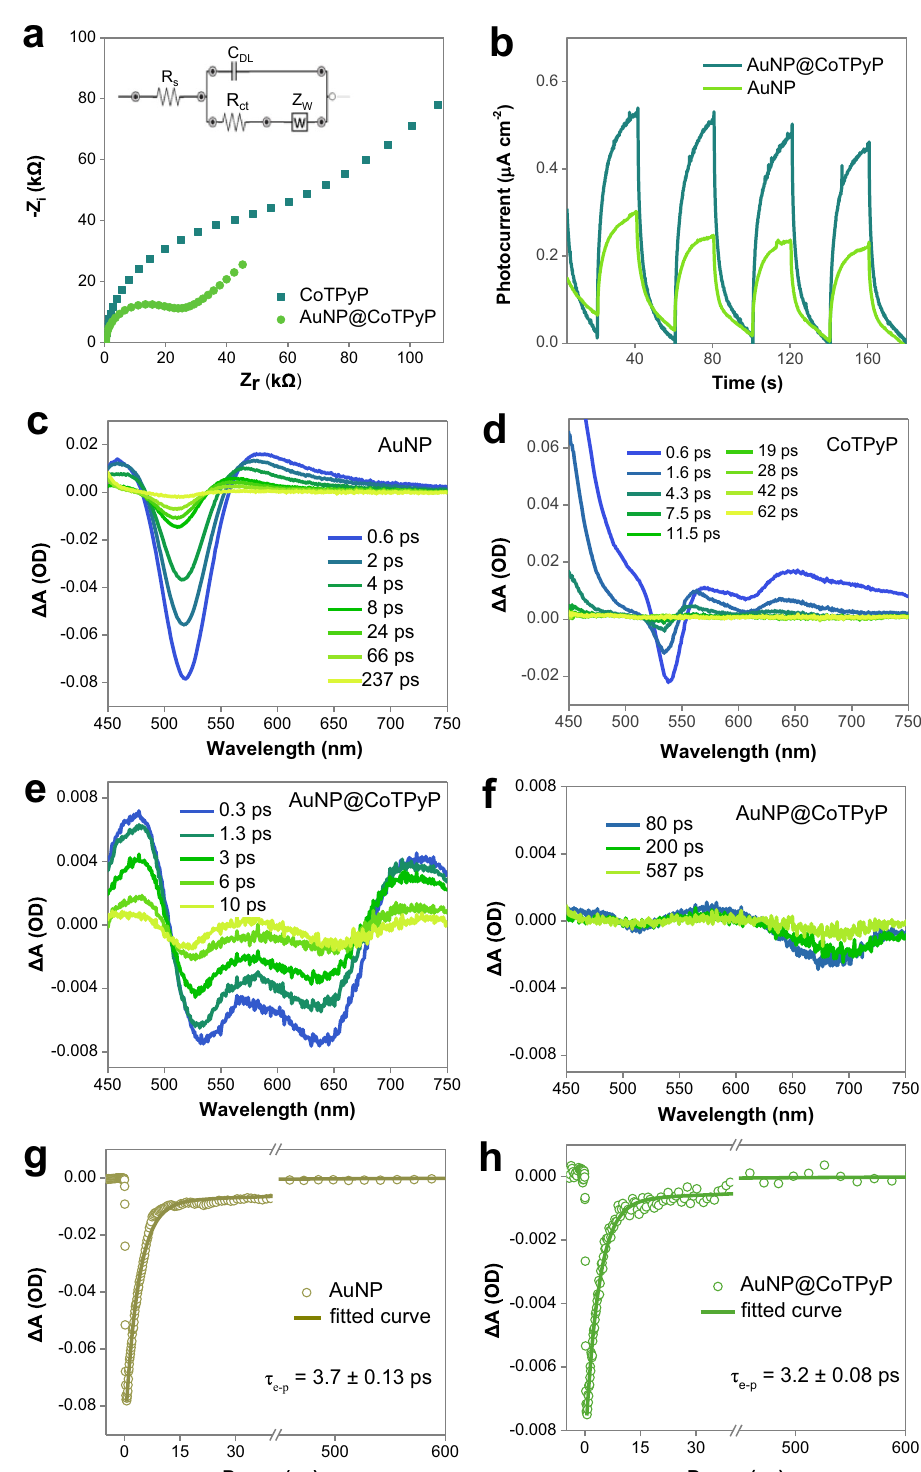
Fig. 5 | Contribution of the enhanced hot carrier transfer in AuNP@CoTPyP photocatalysis. a Nyquist plots of CoTPyP and AuNP@CoTPyP in H 2 SO 4 solution (pH=4). b PhotocurrentmeasurementsoftheAuNPsandAuNP@CoTPyP(CoTPyP concentration = 2nM). The samples were periodically illuminated with green